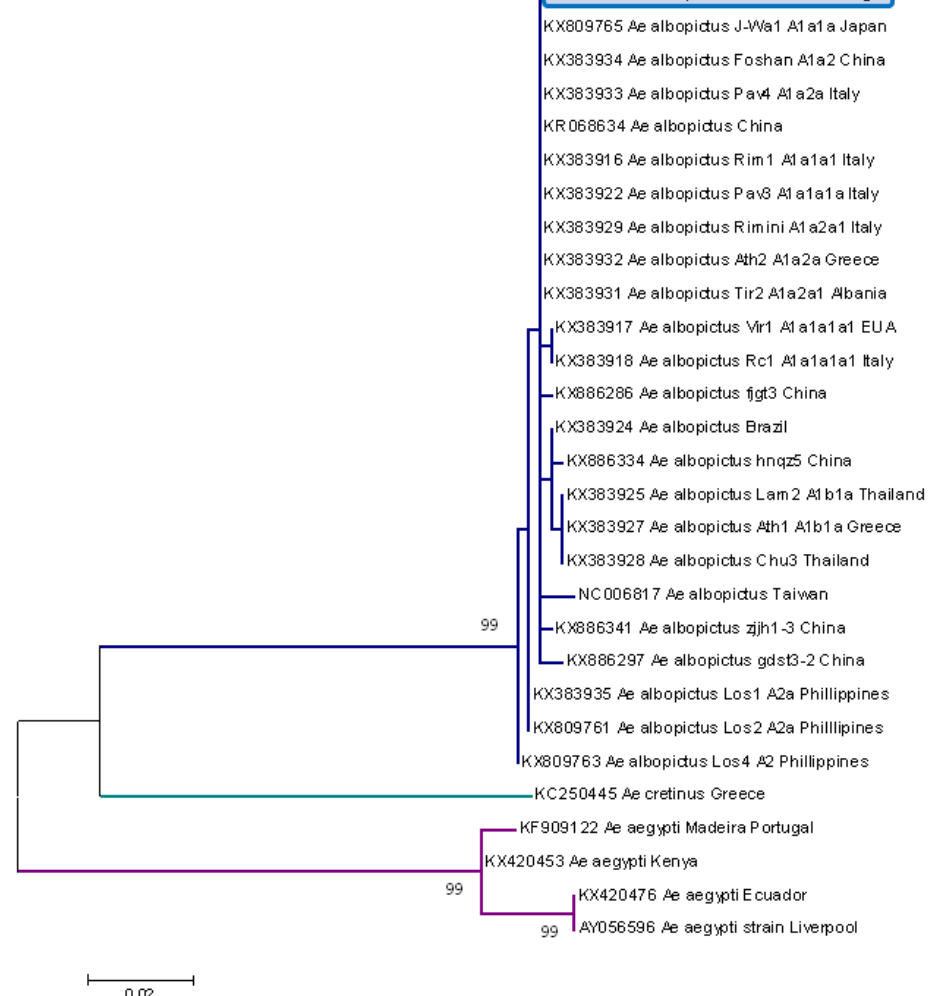
Figure 2. Phylogenetic analysis of Ae. albopictus sequences using partial COI sequence region. The maximum likelihood phylogenetic tree was inferred on the basis of 29 partial cytochrome oxidase I (COI) nucleotide sequences (660 bp) by using Molecular Evolutionary Genetics Analysis (MEGA) version 7 software. Distance matrices were calculated using the T92+G model. Bootstrap values obtained from 1000 replicate trees are shown for key nodes (more than 70%). The scale is shown at the bottom as substitutions per site. GenBank accession number and origin are indicated. The Ae. albopictus sequence related to this work is highlighted in blue.